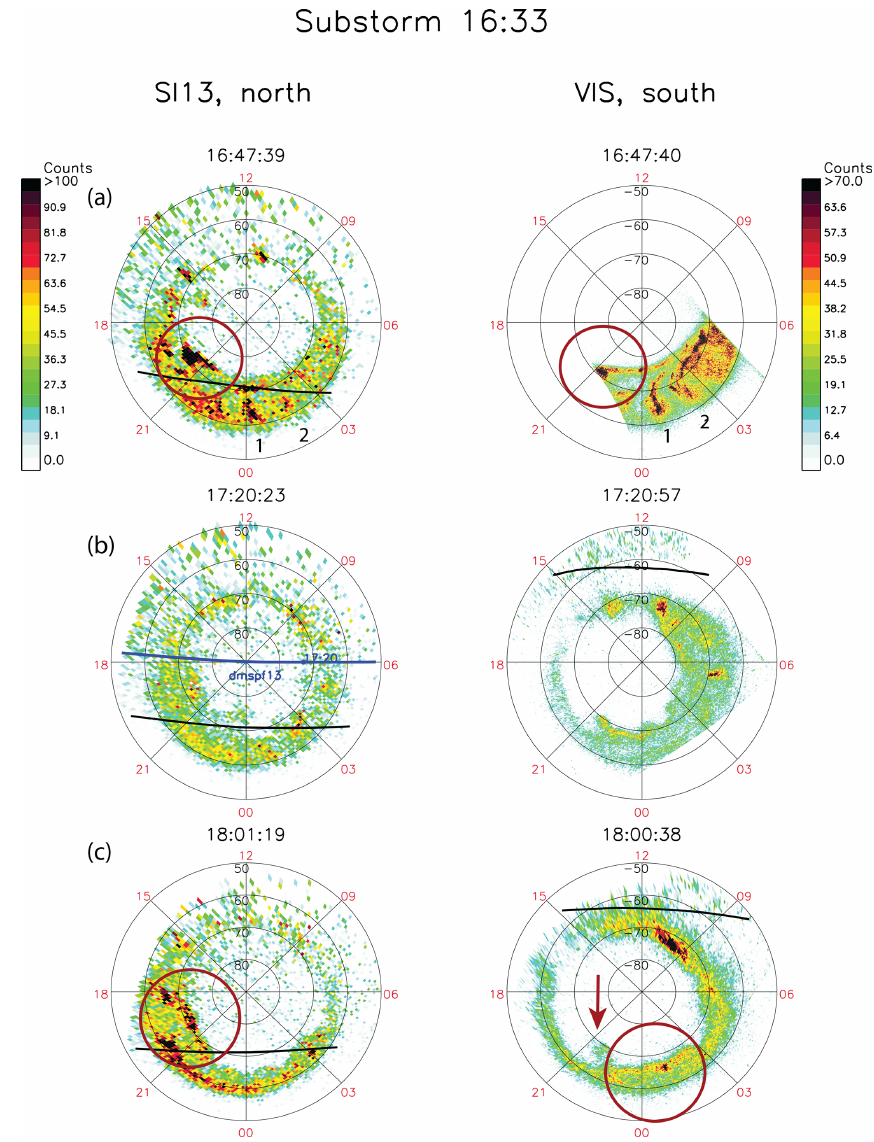
Figure 3. 17 August 2001: (a–c) pairs of simultaneous (as close as possible) auroral images from Northern (left) and Southern (right) Hemispheres. All panels show SI13 and VIS. Black lines indicate the terminator at 90 ◦ solar zenith angle. Features we claim are conjugate are marked with red circles and numbers in panel A. Blue line in panel (b) is the trajectory of the DMSP 13 pass in the Northern Hemisphere. Time of the first substorm is also